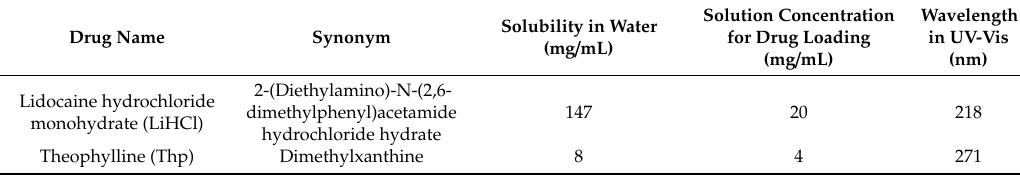
Table 2. Two drugs selected for the drug delivery